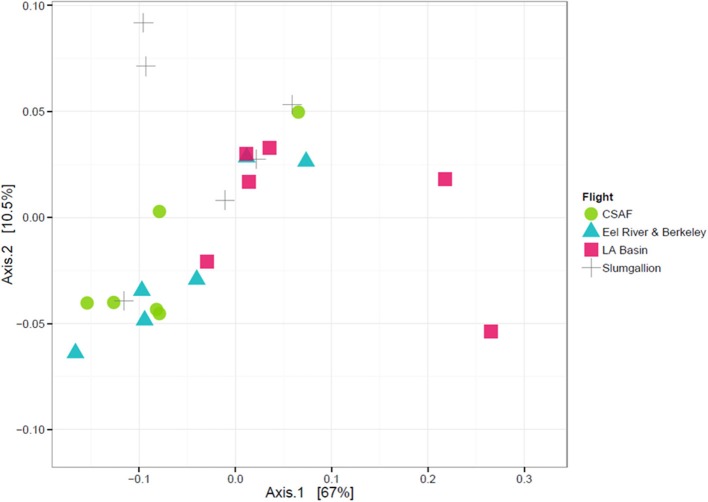
Weighted ordination plot based on OTU abundance showing that samples did not cluster by flight. The first two ordination axes accounted for 77.5% of sample variation.